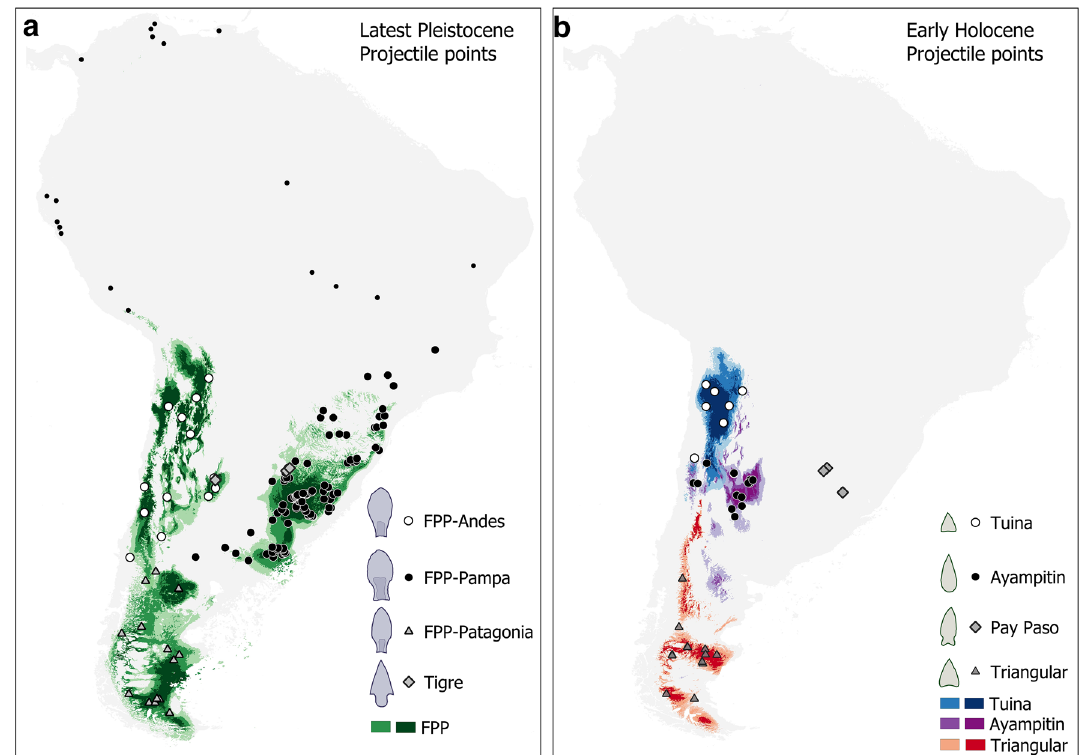
Figure 1. Spatial distribution of southern South American projectile points. Maps showing the potential distribution of latest Pleistocene ( a ) and early Holocene projectile points ( b ). Colors represent potential for distribution values above 0.6 (light colors) and 0.8 (strong colors). For Tigre and Pay Paso projectile points only the sites were graphed because of the small sample size. Northern South American sites with Fishtail projectile points also were graphed as small black points. Map generated with QGIS 3.16 ’Hannover’ (https:// qgis. org/ en/ site/ index.